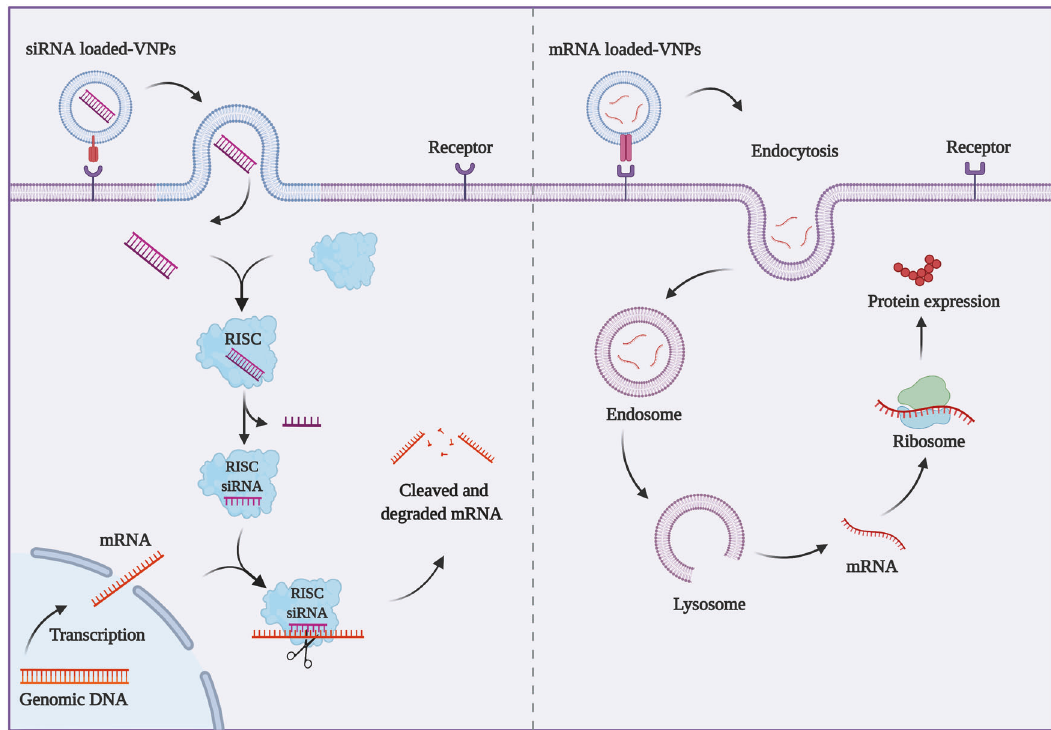
Fig. 5 Mechanism of delivering siRNA and mRNA for gene therapy based on VNPs. siRNA or mRNA loaded-VNPs can be internalized into the cytoplasm of the target cells via recognition of glycosylated cell surface receptors on the surface of host cells. siRNA released in the cell cytoplasm will bind to RNA-induced silencing complex (RISC) with the target mRNA and knockdown the speci fi c protein expression in cells. The packaged mRNA is translated into protein after its delivery to the